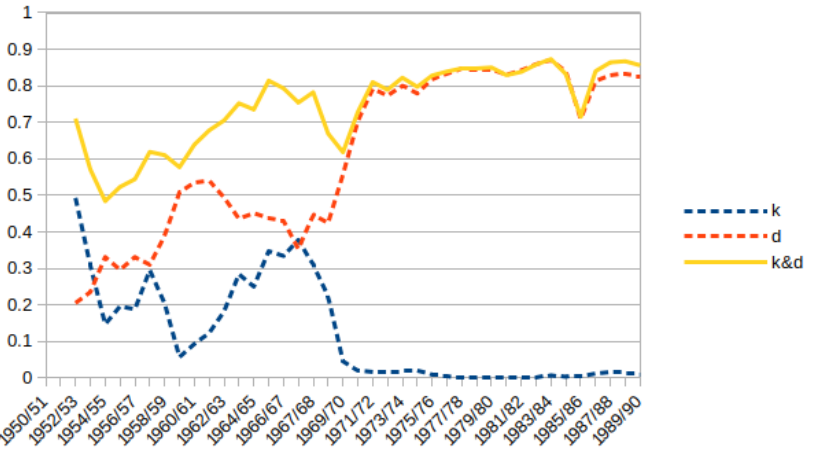
Figure 5. Sensitivity analysis with respect to the parameters κ and δ ( R 2 from regressions of θ KS on κ , κ 2 (k), δ , δ 2 (d) and κ , κ 2 , δ , δ 2 , κδ